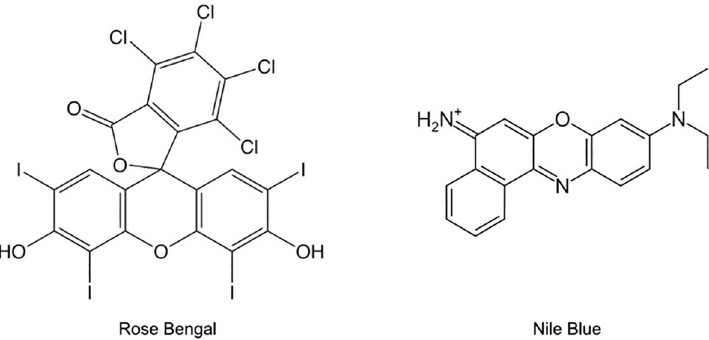
Fig 1. Structures of the hydrophobic (Rose Bengal) and hydrophilic (Nile Blue)